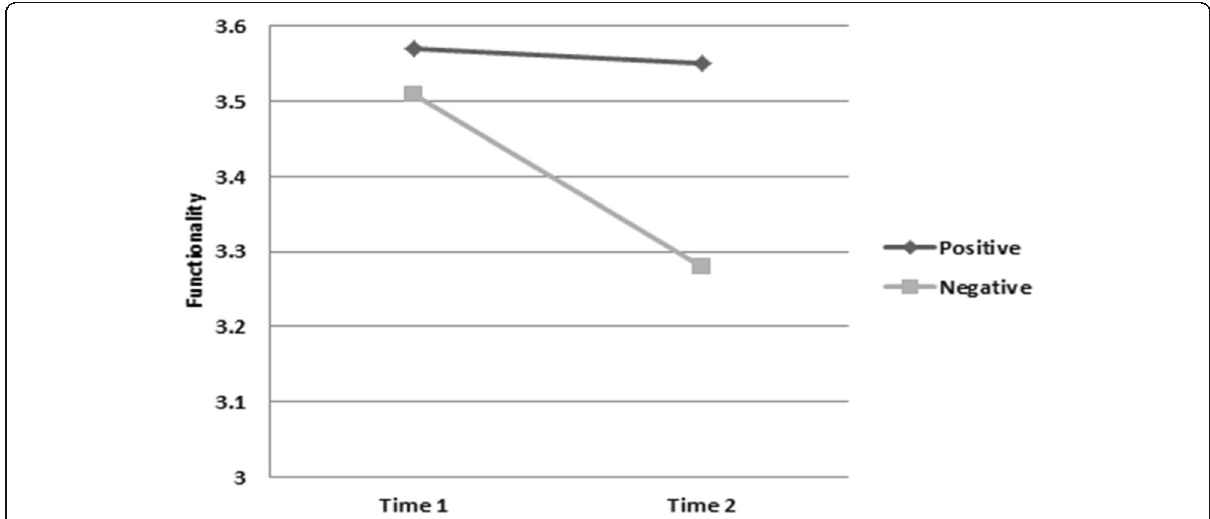
Fig. 4 Functionality means by condition at Time 1 and Time. The figure shows the difference in the mean perception of functionality between time 1 prior to exposure to the label and time 2 after exposure to the label. As shown, exposure to both label conditions reduced perceptions of functionality. However, this effect was far more drastic for the negative label condition, with perceived functionality reducing